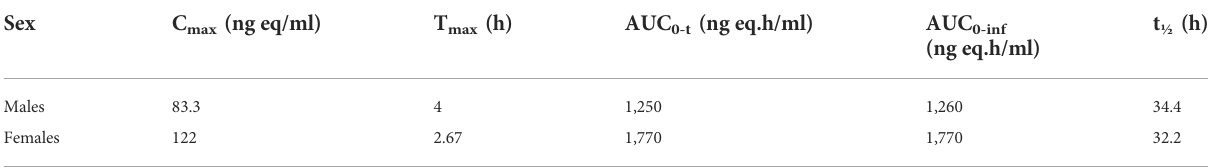
TABLE 2 Plasma radioactivity pharmacokinetic data following an oral dose of [ 14 C]-zapnometinib (30 mg/kg) to male and female rats.